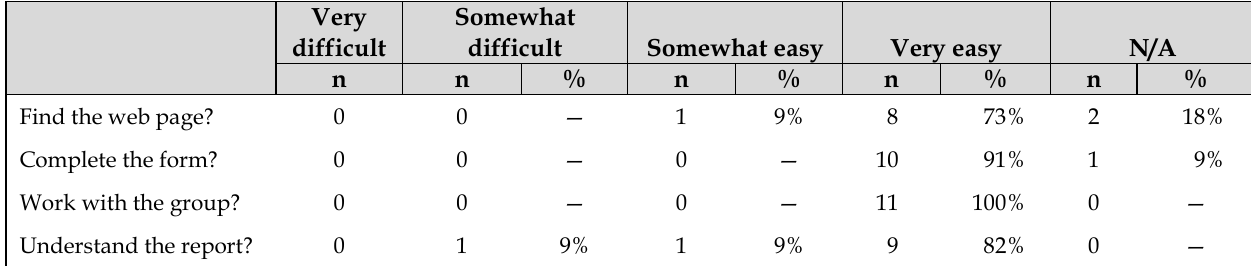
Table 2 Perceived ease of engaging with each aspect of the